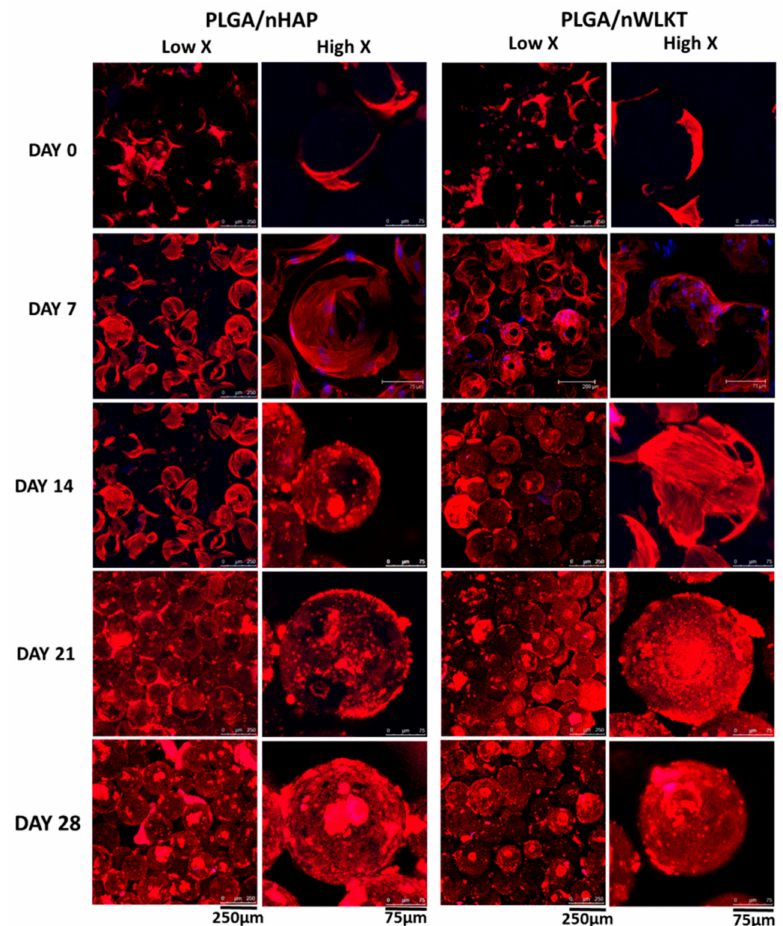
Figure 5. Visualization of the cytoskeletal arrangement in PLGA / nHAP and PLGA / nWLKT sca ff olds through F-actin staining at low and high magnifications. Cell cytoskeleton was labeled with red fluorescence-producing phalloidin-tetramethylrhodamine B isothiocyanate and cell nuclei were counterstained with blue fluorescence-producing Hoechst 33,342 (Bar: low X = 250 µ m, high X = 75 µ